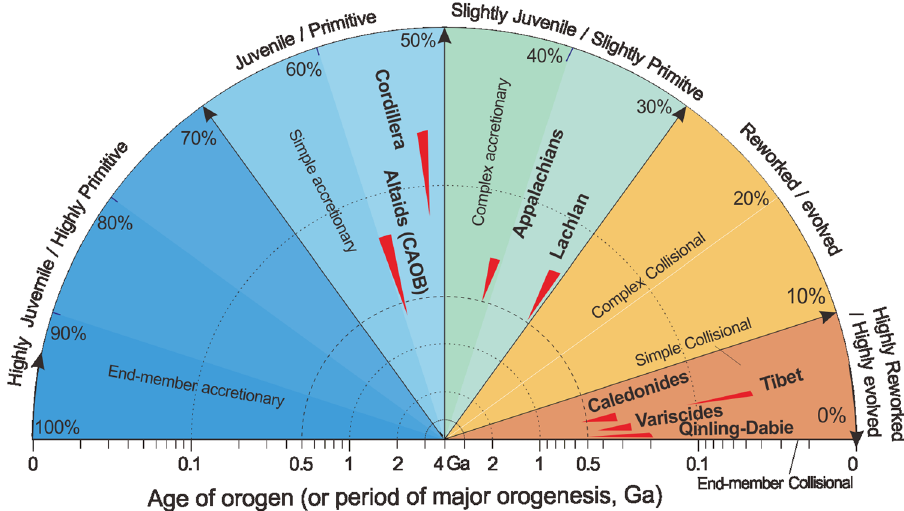
Fig. 5 A hemispheric diagram showing the classi fi cation and characteristics of orogens in terms of their compositional architecture (areal percent of juvenile compositions) and ages of orogens. Sectors represent a continuous transition from highly primitive (juvenile crust 100%) to highly evolved (juvenile crust ~0%) compositions. Concentric semi-circles with logarithmic coordinates denote the age range of the orogens (such as 500 – 340 Ma for the Lachlan